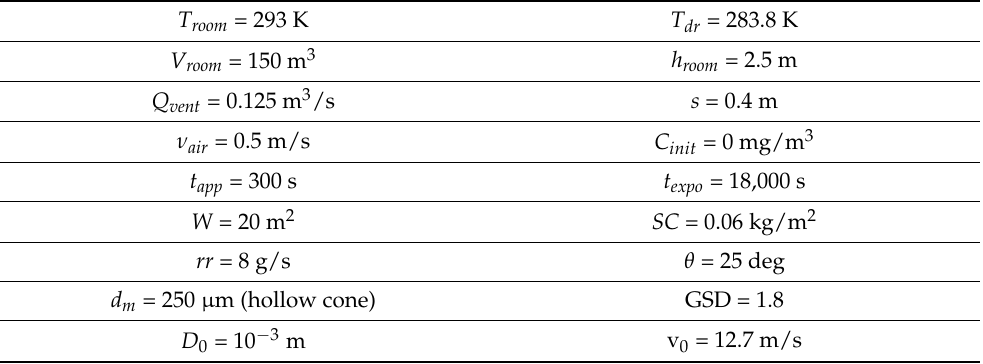
Table 1. Scenario-related parameters. T room = 293 K T dr = 283.8